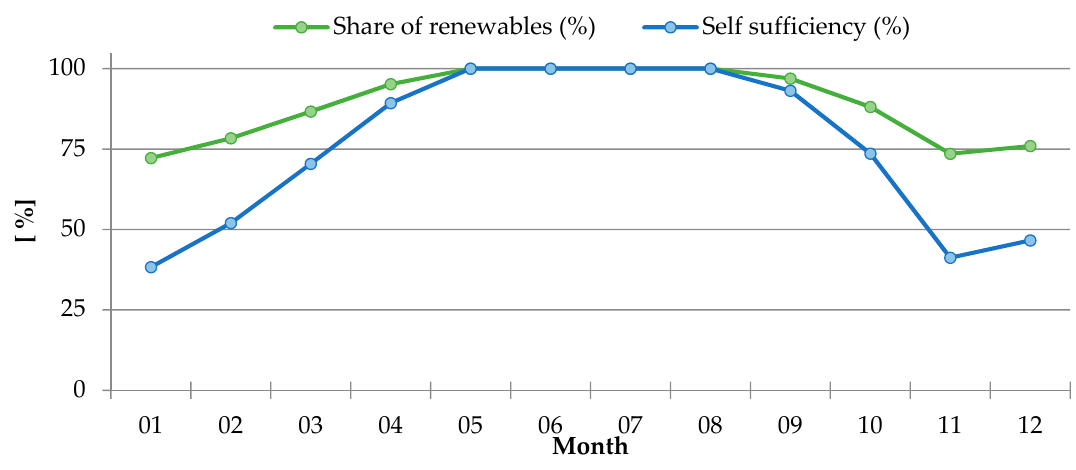
Figure 3. Battery scenario: Monthly share of renewables and self-sufficiency.